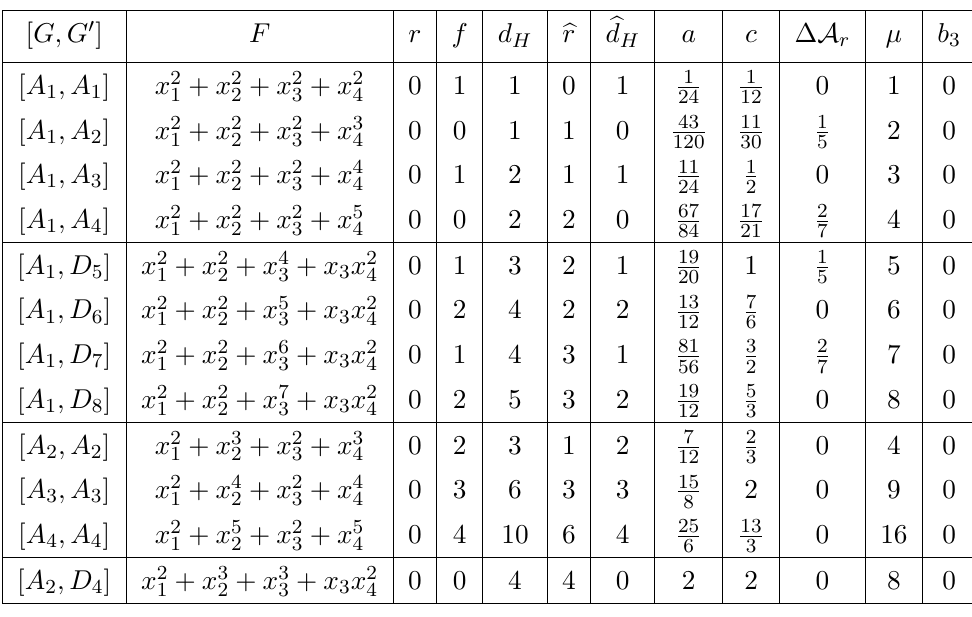
= AD [ G, G 0 ] . Here, a and c are X ] ∼ = [ A ] . 2 , A 2 1 , D 4